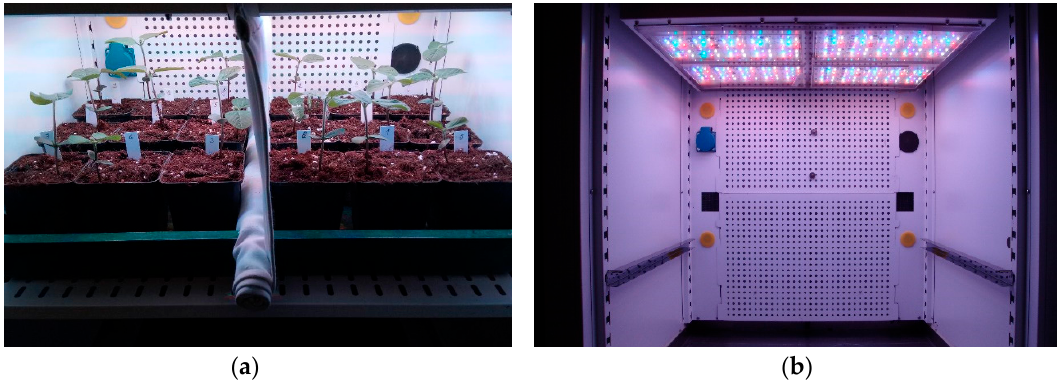
Figure 1. Soybean within the chamber ( a ) and the empty chamber showing the LED modules ( b ).